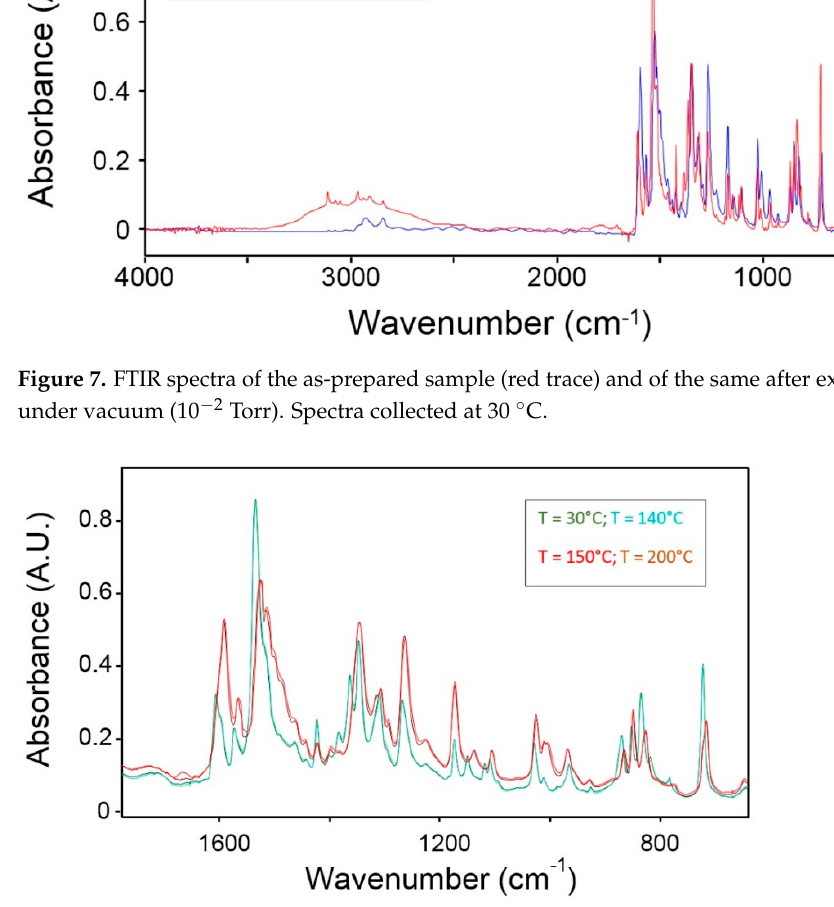
Figure 9. Absorbance area of the H 2 O band at 3000 cm − 1 and residual water content in the sample as a function of temperature. The inset compares the FTIR spectra in the 3800–2000 cm − 1 range collected at 140 °C (blue trace) and 150 °C (red trace).